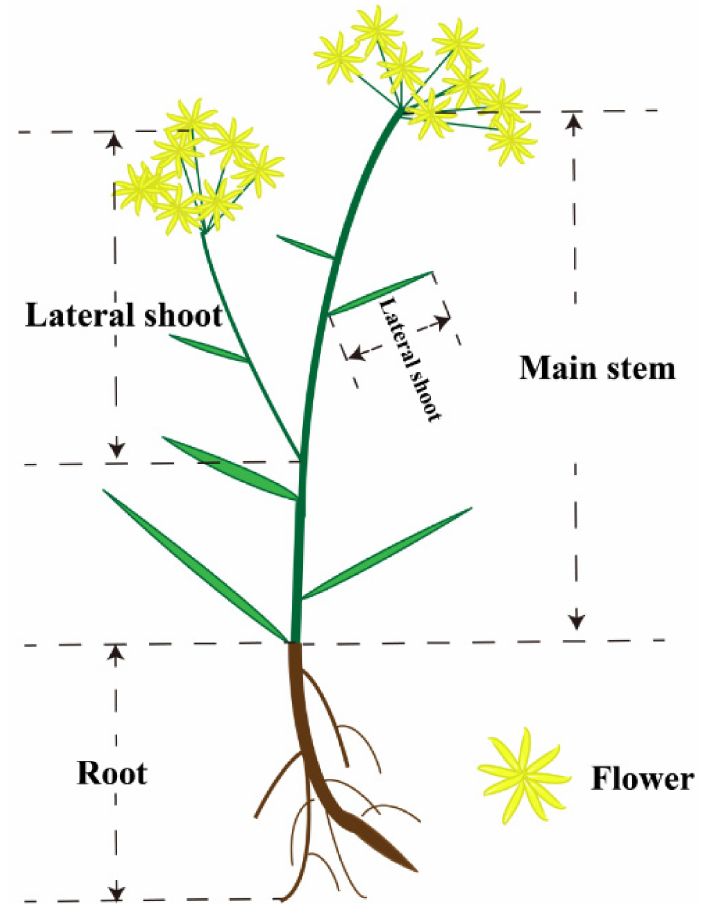
Figure 1. The whole Bupleurum was divided into four organs, which are the root, main shoot, lateral shoot and flower.